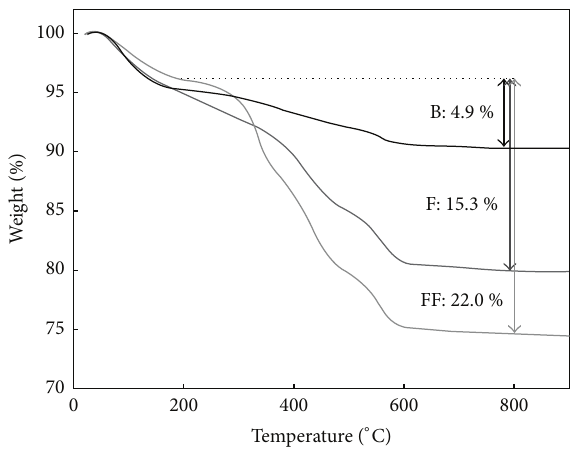
Figure 3: Thermogravimetric analysis of bare and fluorinated silica nanoparticles. B denotes the untreated silica nanoparticles. F and FF denote the low and high fluorinated samples, respectively. The weight lossbetween 200 and 800 ∘ Cfor each sampleis presented next to the sample label.